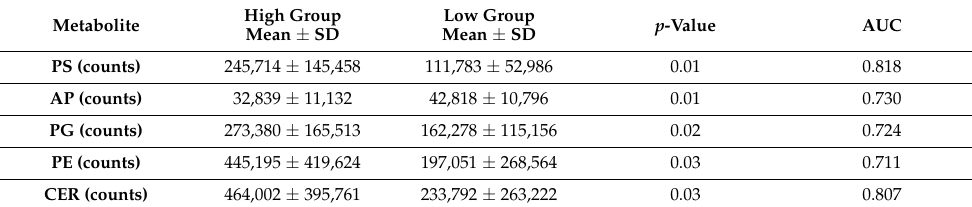
Table 2. Student’s t -test and area under the curve for the significantly different metabolites used to discriminate between patients with low and high tacrolinemia. The mean levels of the metabolites represent peak UHPLC–MS